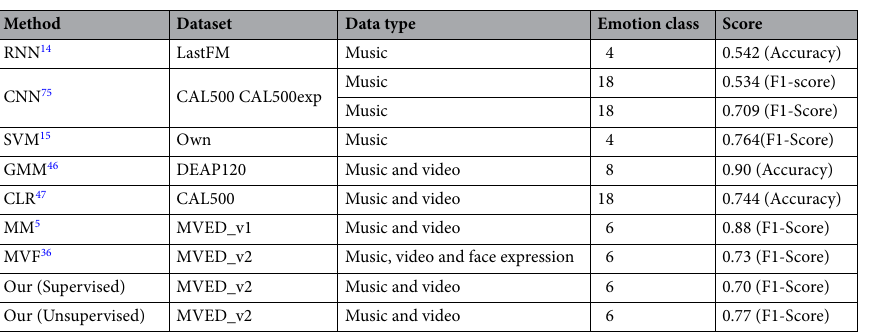
Table 3. Comparisons with past